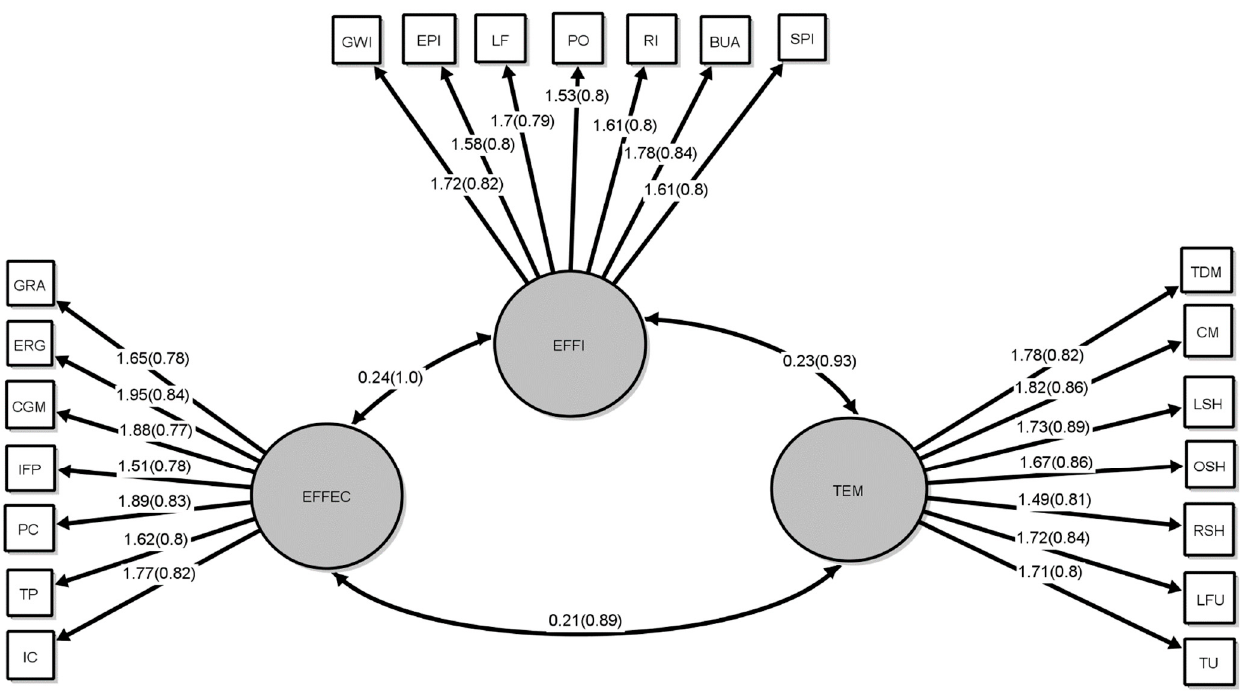
Figure 8. Confirmatory factor analysis of the relationships among GWG governance dimensions of Khon Kaen city from the stakeholders’ perspectives.